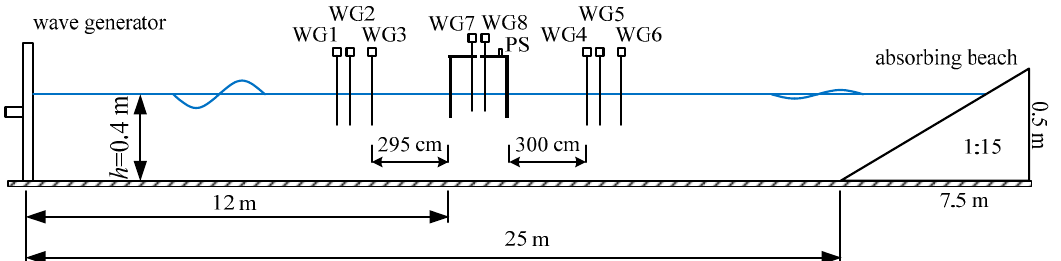
Figure 3. A sketch of the experimental setup.